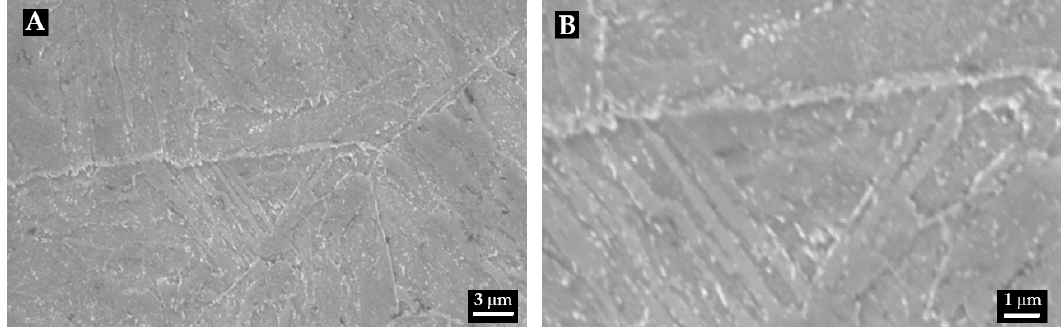
Figure 7. SEM micrographs of the sample quenched and tempered at 590 °C for 6 h + 590 °C 4 h at low magnification ( A ) and higher magnification ( B ).